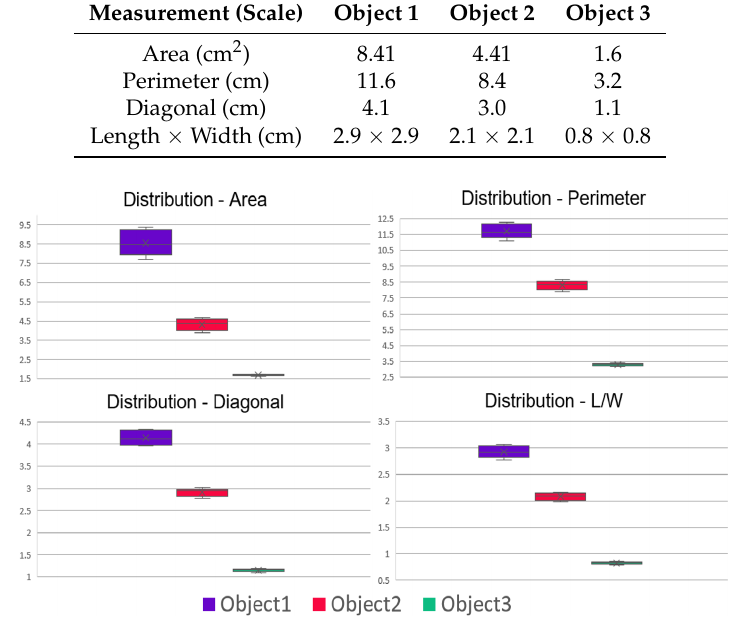
Figure 8. Distribution of measurements performed using proposed heuristic calibration method. Object 1 is the largest object from Figure 7, Object 2 is the second largest object, and Object 3 is the smallest